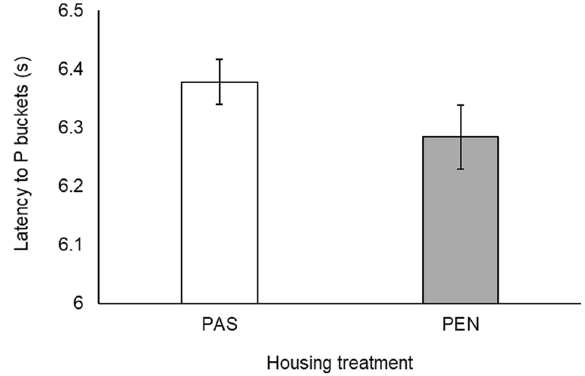
Figure 4. Response latency to the positive (P) bucket location in each housing treatment (pasture access: PAS; cubicle housing: PEN). Error bars represent standard error of the mean.